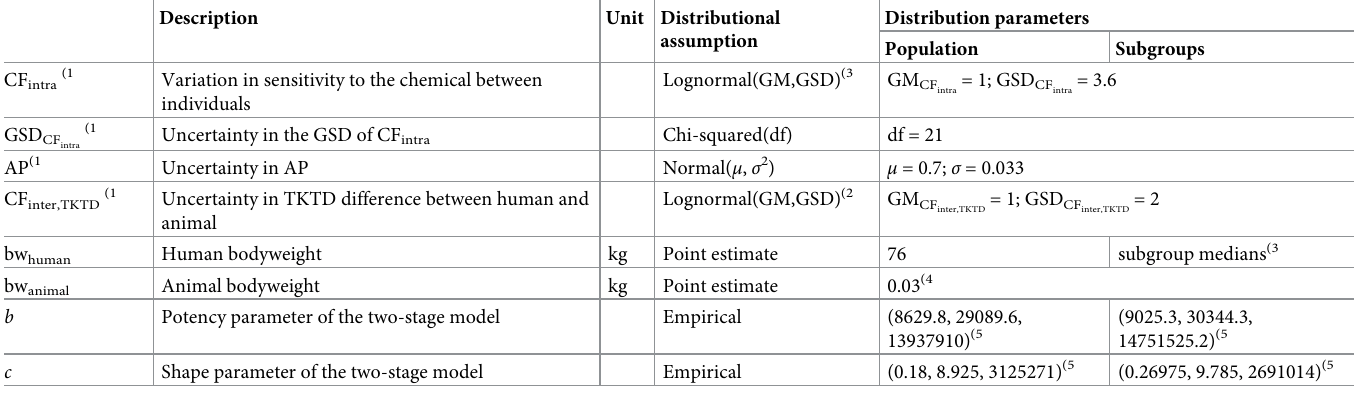
Table 3. Model parameters and distributional